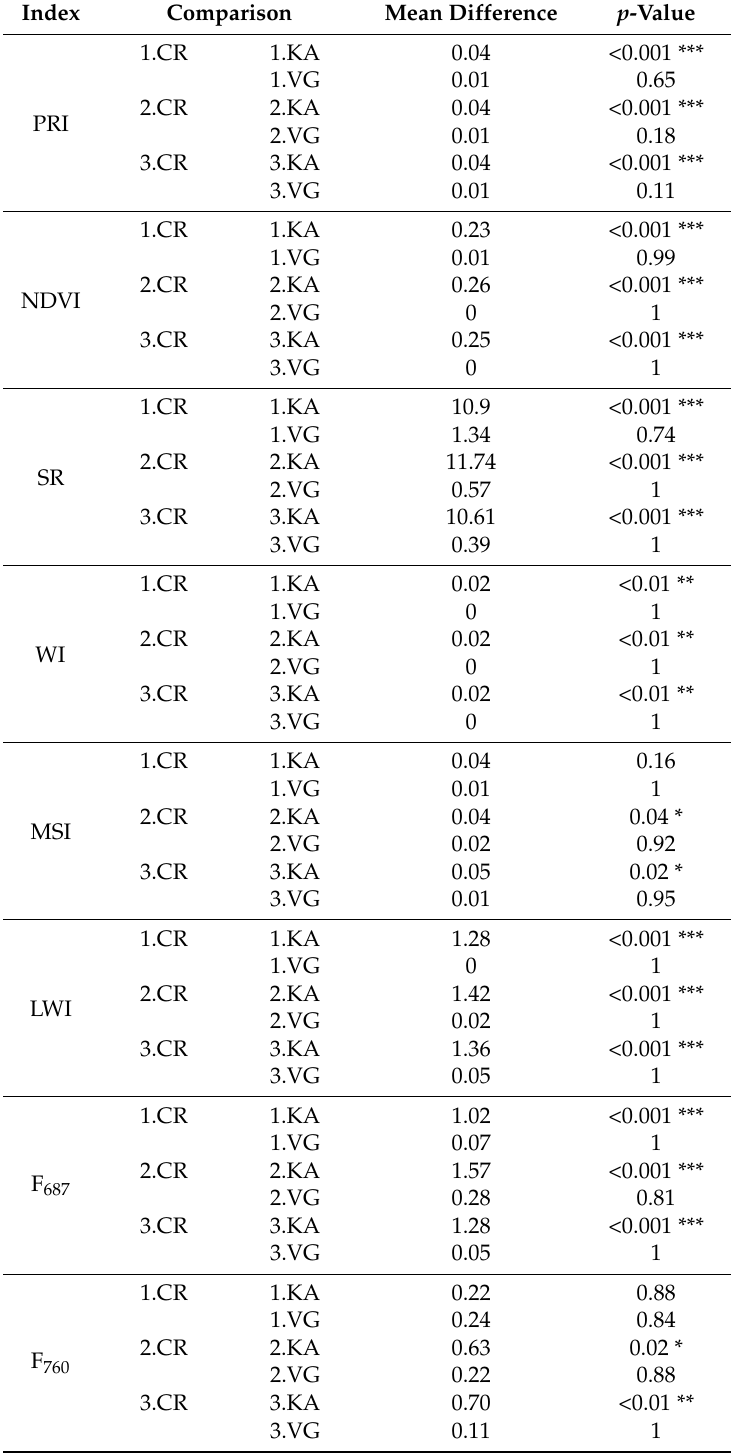
Table A3. p -values (level of statistical significance: *** p < 0.001, ** p < 0.01, * p < 0.05) of Tukey’s HSD pairwise comparison and mean differences of treatments (CR, KA, VG) for VNIR/SWIR based indices and F 687 and F 760 at three HyPlant